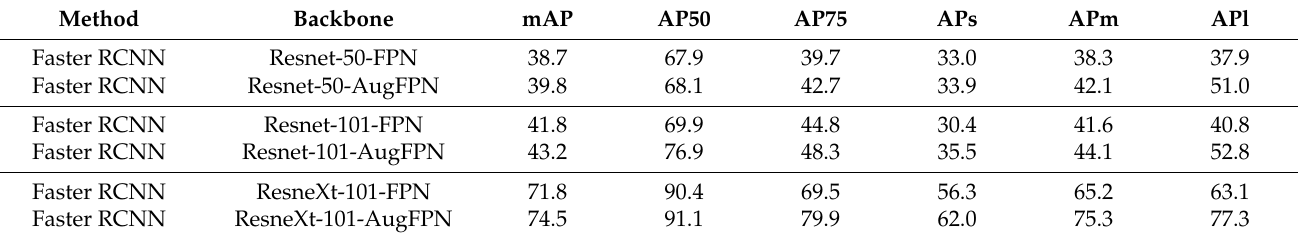
Table 7. Ablation Studies of AugFPN.